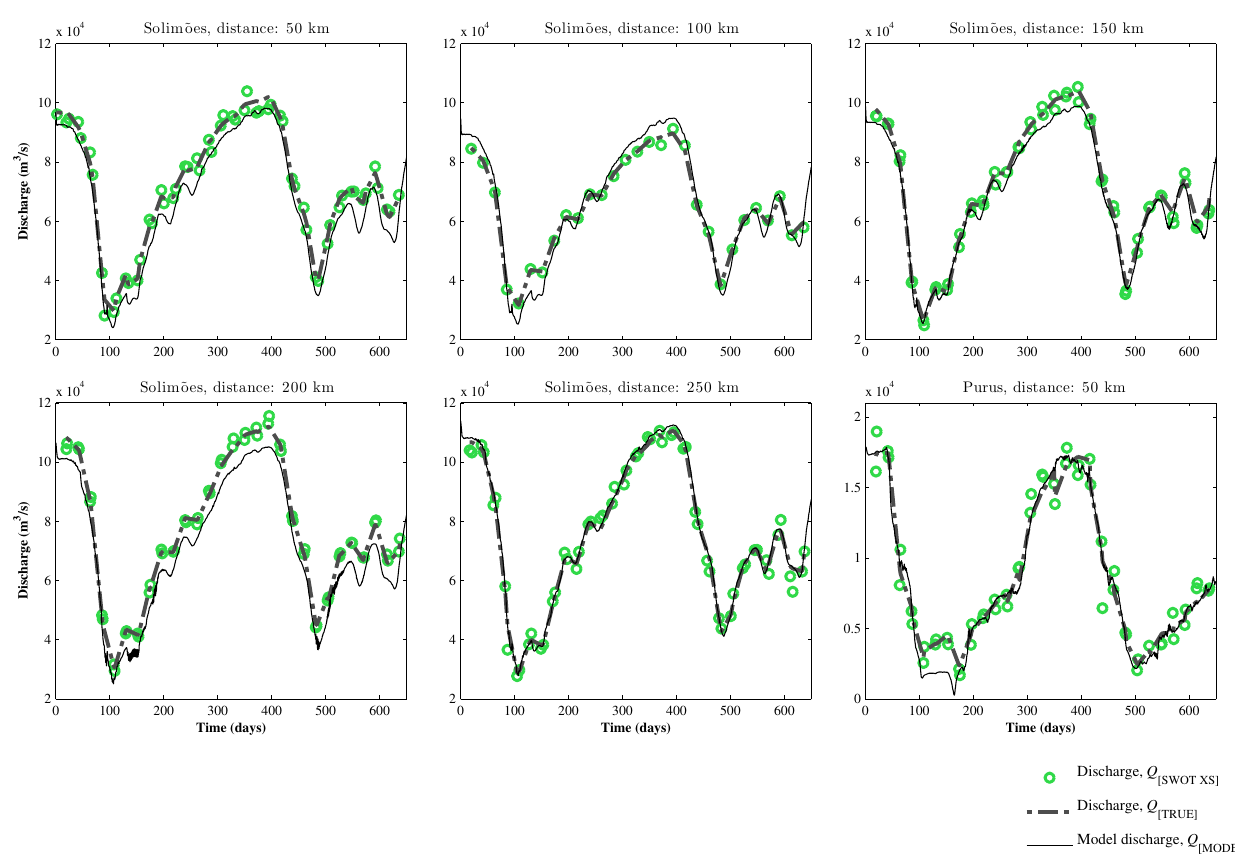
Figure 12. Reconstruction of channel discharge hydrographs from cross-section-averaged SWOT observations ( Q [ SWOTXS ] ) for the Solimões and Purus channels using 20km reach lengths, compared to discharge obtained using water elevation “truth” images ( Q [ TRUE ] ) and the original modelled channel discharge ( Q [ MODEL ]